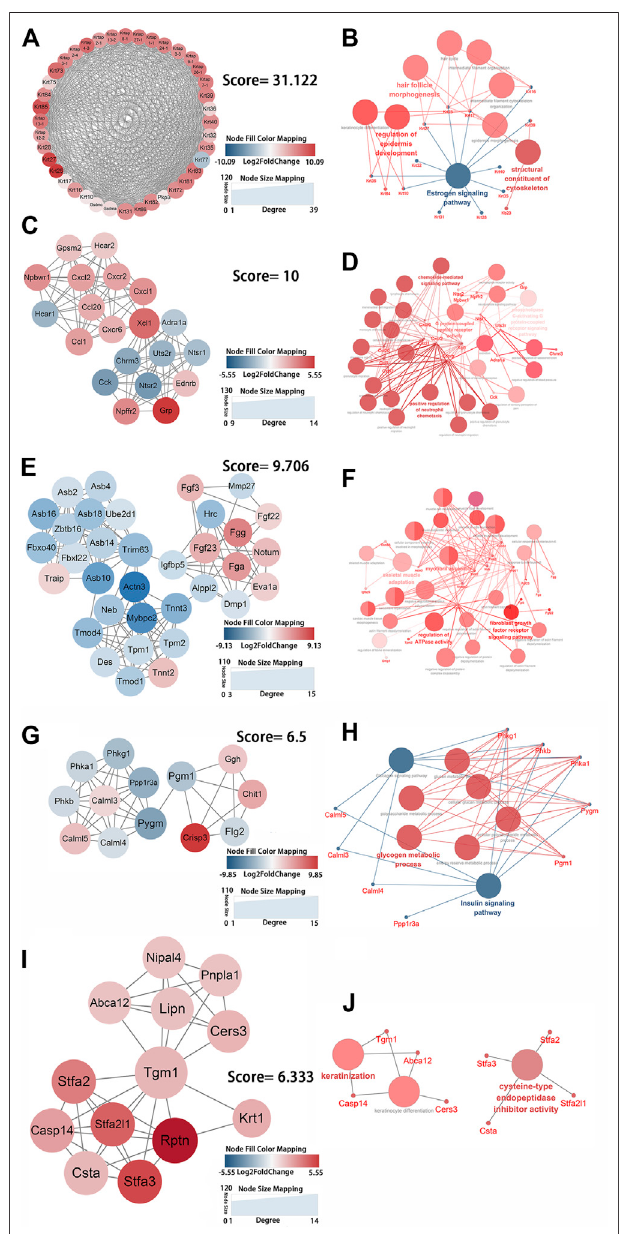
FIGURE 4 | Identi fi cation of the key protein clusters using string databaseand MCODE plugin (nodes > 10,score > 5) and functional analysisof